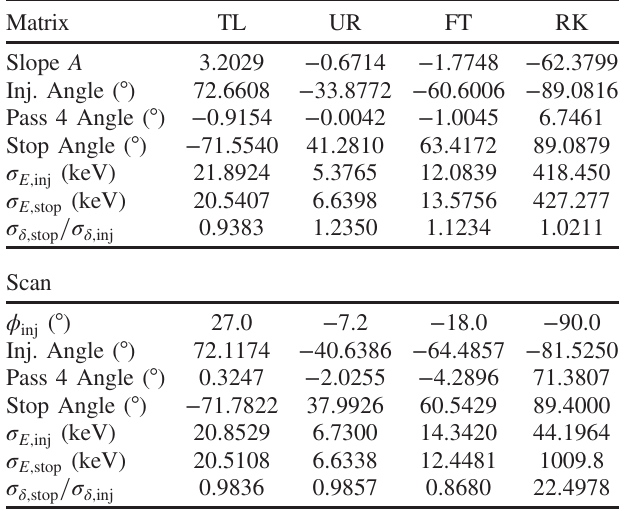
tilted to match the Table V profiles will most effectively TABLE V. Beam tilt parameters for a symmetric injector-stop